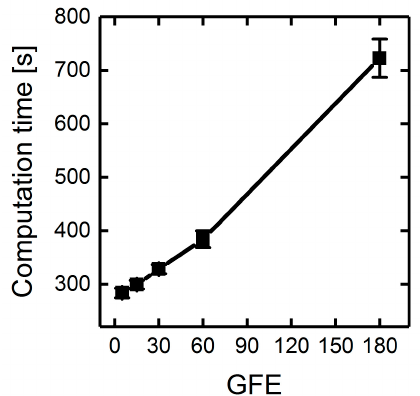
Figure 8. Absolute computation time of 900 generations for several pairs of GFEs and generation sizes. Deletion of maximally seven reactions were allowed. Succinate BPCY was used as the engineering objective. Error bars denote the standard deviation of five replicate GA runs.